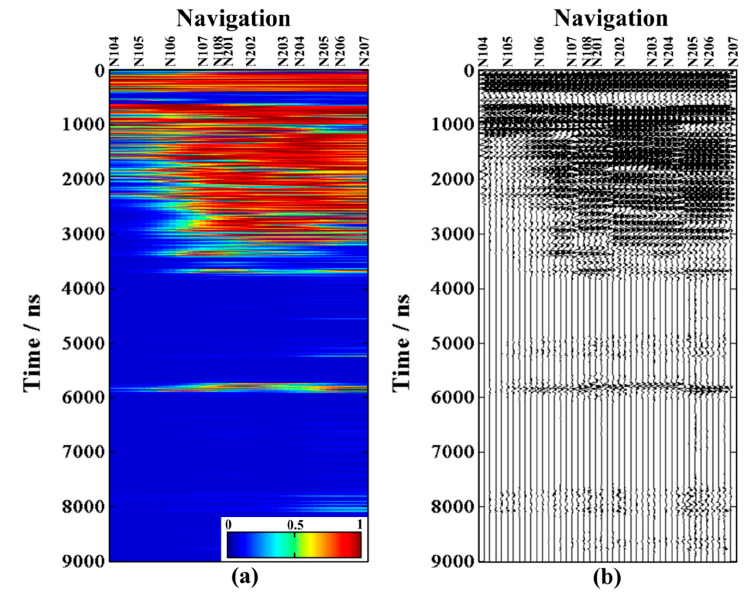
Figure 8. ( a ) Local correlation map and ( b ) final extracted signal.